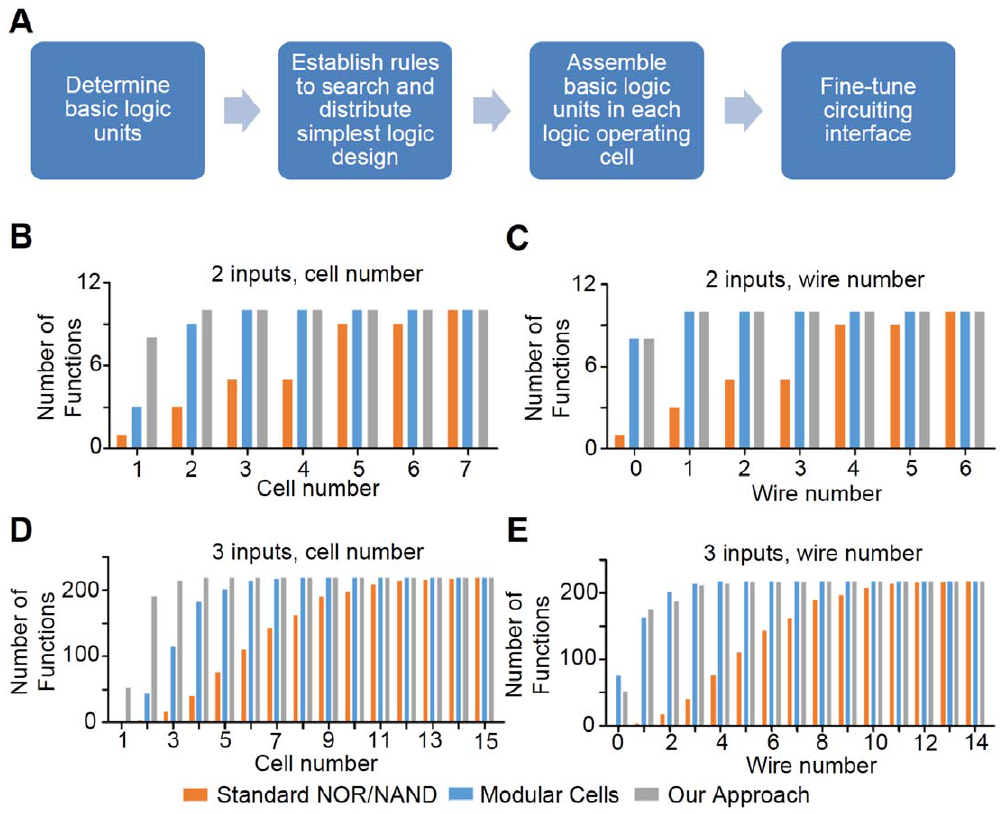
Figure 1. Work flow for the formalized design process and insilico analysis of different approaches in multicellular logic circuits. (A). Schematic view of the work flow for formalized design process. (B). Number of permissible 2-input 1-output Boolean functions versus the number of cells required for their implementation. Each bar represents number of functions that can be implemented within a certain number of cells. Different colors denote different approaches: orange for Standard NOR/NAND, blue for Modular Cells, and gray for our approach of combinational design. (C). Number of permissible 2-input 1-output Boolean functions versus the number of chemical wires required for their implementation. (D) and (E) show the results for 3-input 1-output Boolean functions.